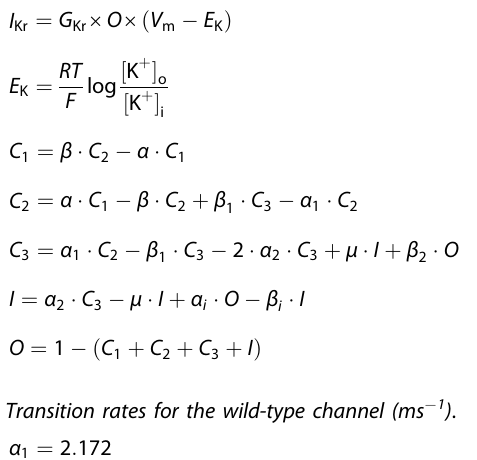
I Kr Markov chain model formulations